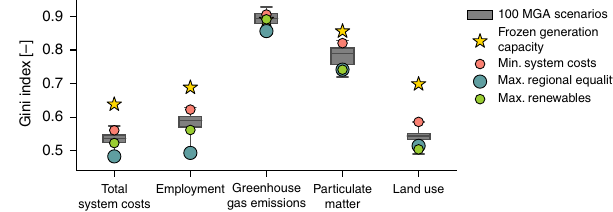
Fig. 7 Gini index of regional impacts. Box plots (in gray) show the Gini index for the spatial distribution of regional impacts on system costs, employment, greenhouse gas emissions, particulate matter emissions, and land use for 100 modeling to generate alternatives (MGA) scenarios. In addition, we highlight the Gini index of regional impacts for the four distinct scenarios of frozen generation capacity, minimum system costs, maximum regional equality of system costs, and maximum renewable electricity generation. A Gini index of 1.0 indicates perfect regional inequality and a Gini index of 0.0 indicates perfect regional equality. Box plot elements: center line, median; box limits, upper and lower quartiles; whiskers, minimum and maximum values. MGA scenarios are generated with a slack of 20% above total levelized electricity generation costs of the cost-optimal solution in EXPANSE and assuming that each country meets its national electricity generation targets for 2035 (see “ Methods ” ). Source data are provided in Supplementary Data